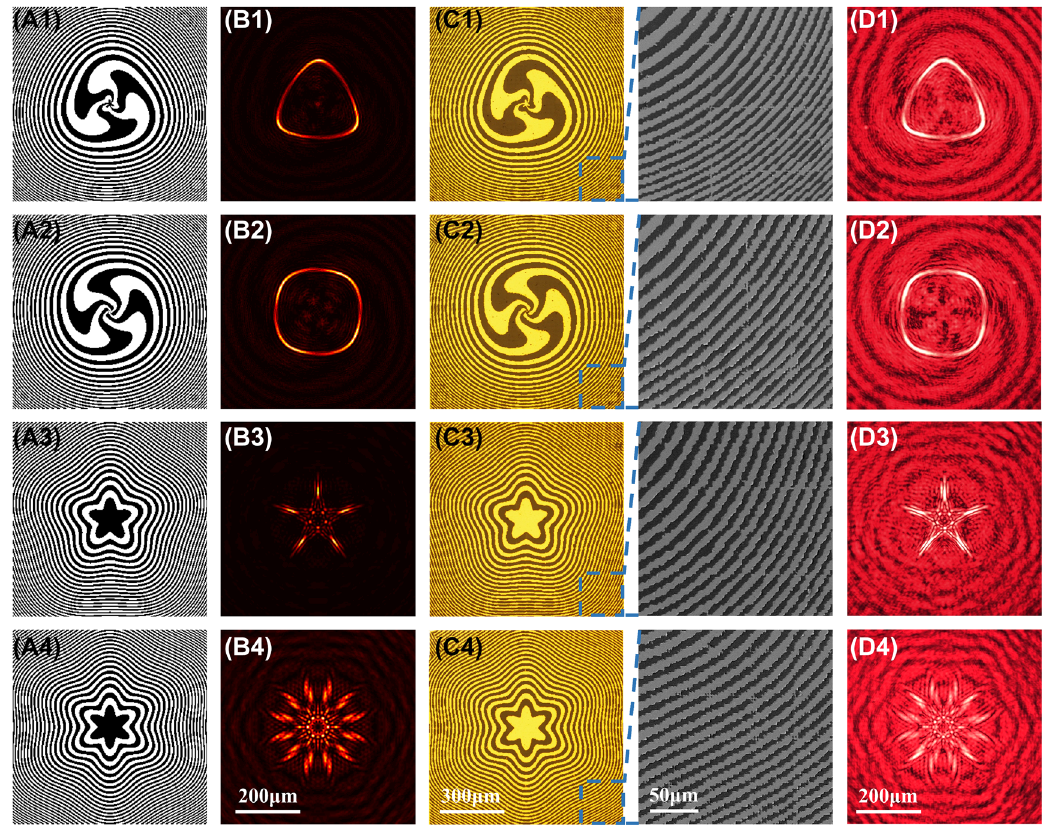
Figure 4: Demonstration of the PZPs. (A1–4) Examples of PZPs (600 × 600 px) with focused patterns: Triangle-like, square-like, and star-like with five arms and twelve arms, respectively. (B1–4) simulated intensity distributions at the focal planes of the calculated PZPs. (C1–4) microscopy images and local enlarged SEM images of the fabricated PZPs. (D1–4) corresponding measured intensity distributions at the focal